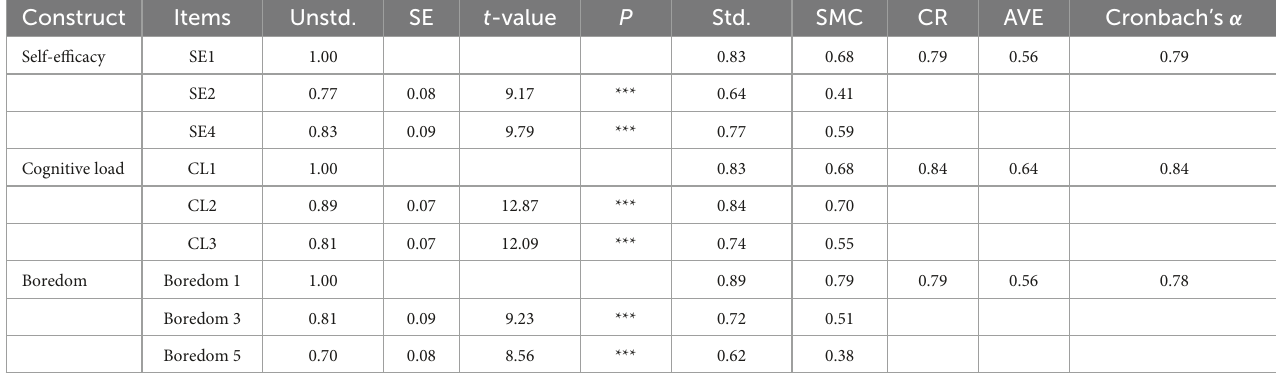
TABLE 3 Coefficient for the measurement